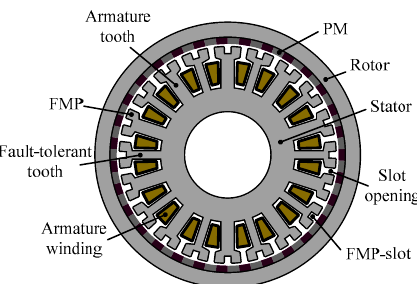
Figure 1. Fault ‐ tolerant permanent ‐ magnet vernier (FT ‐ PMV) machine. Figure 1. Fault-tolerant permanent-magnet vernier (FT-PMV) machine.